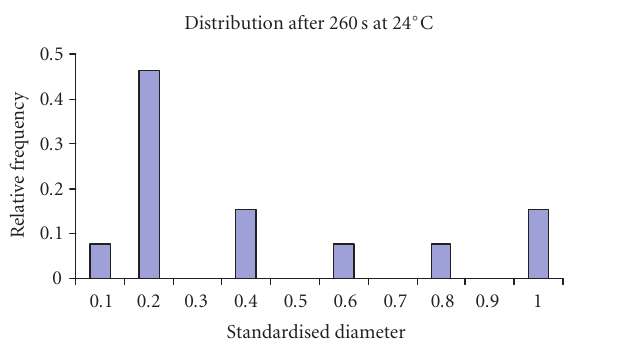
Figure 4.1. Histogram of the bubble size distribution which corresponds to the distribution function 260 s after foaming up which is shown in Figure 3.18(b).